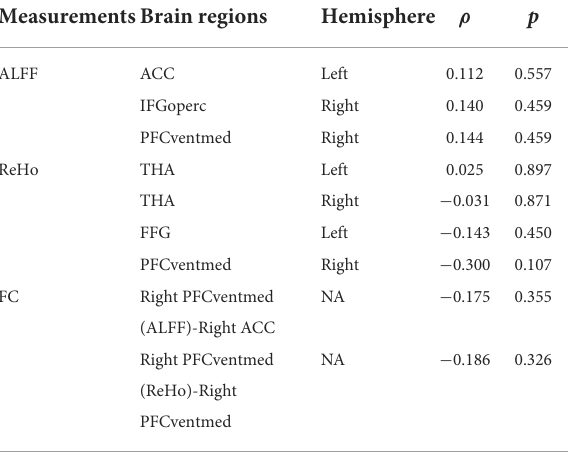
TABLE 3 Results of Spearman correlation between neuroimaging indices and pain scores in BMP patients. Measurements Brain regions